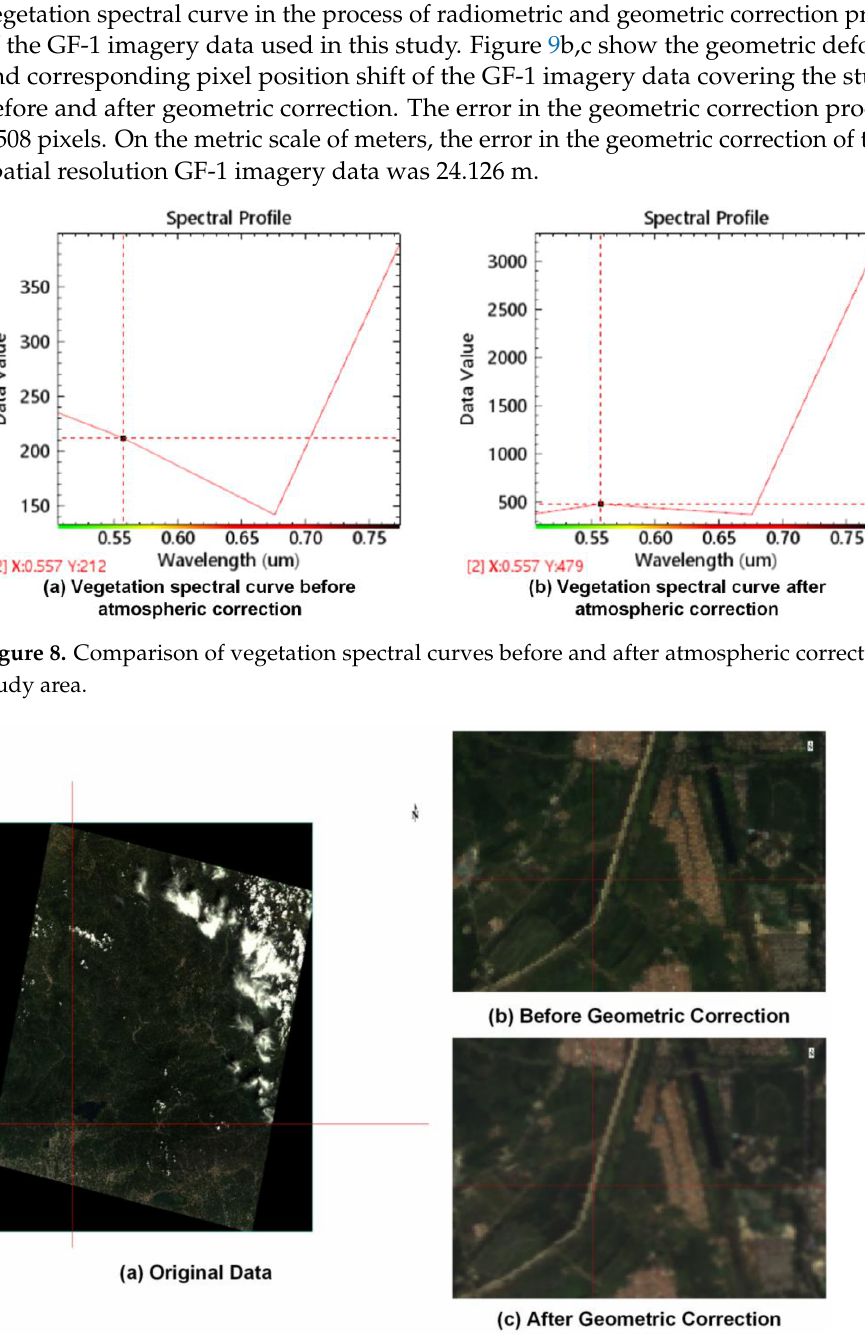
Figure 9. Comparison of the study area before and after geometric correction.